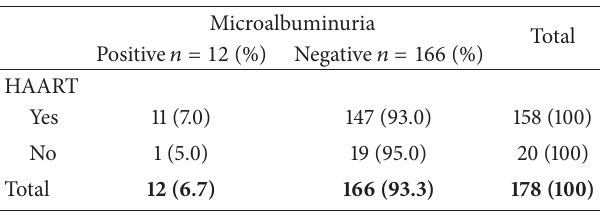
Table 8: Microalbuminuria and use of highly active antiretroviral